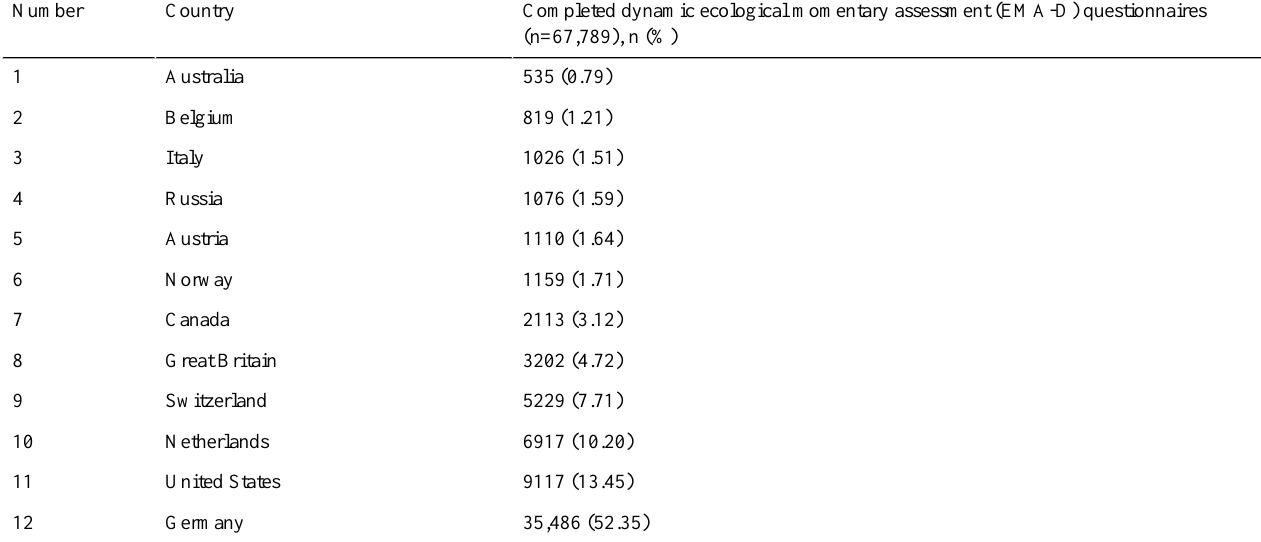
Table 2. Country distribution of TrackYourTinnitus (TYT) users (n=2065) in ascending